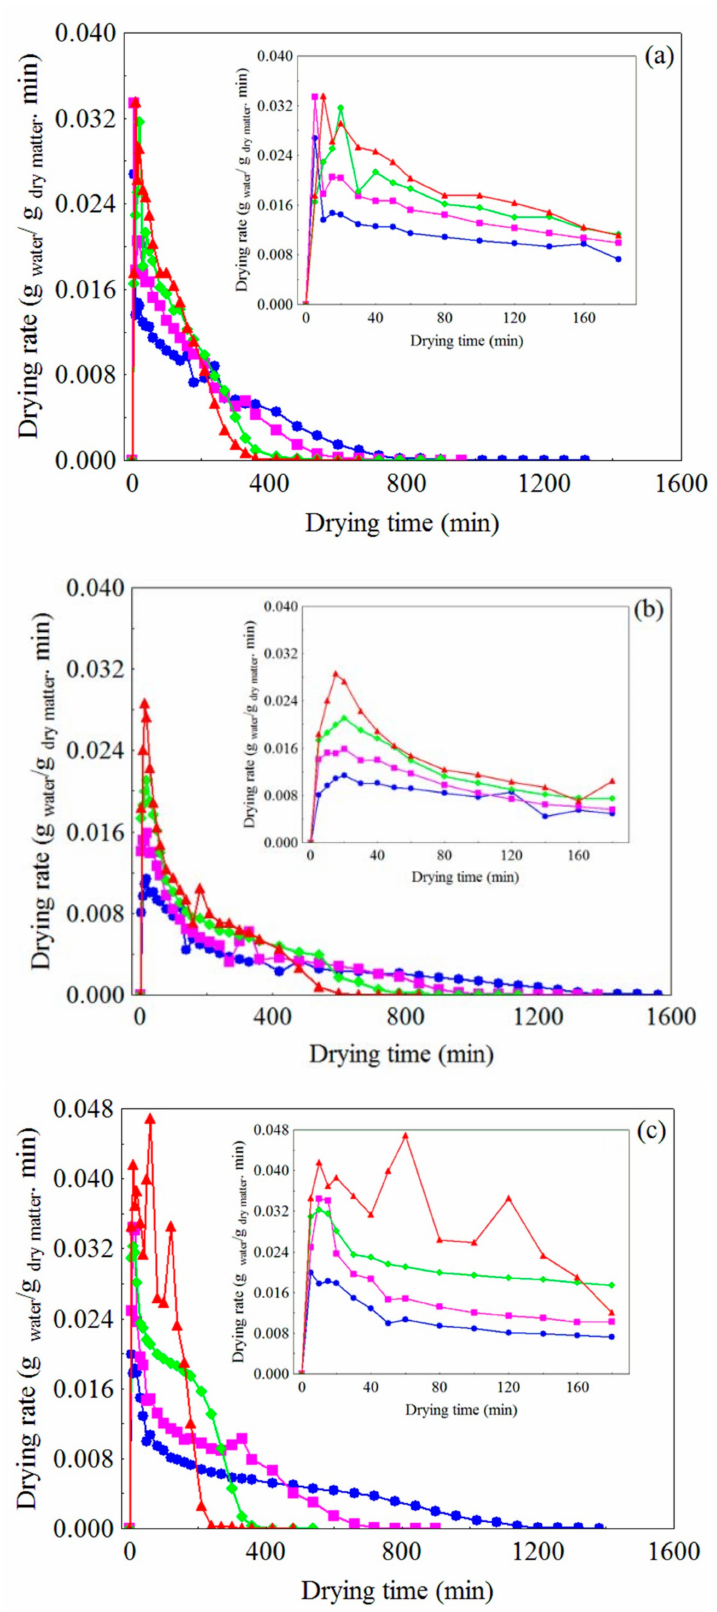
Figure 2. Variation of drying rate over time at different air temperatures for ( a ) WR, ( b ) CR and ( c ) FR: ( ) 50 ◦ C, ( ) 60 ◦ C, ( ) 70 ◦ C, ( ) and 80 ◦